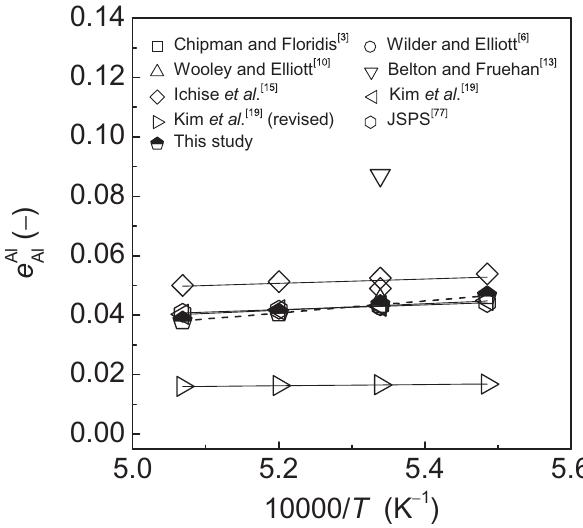
Figure 13: Comparison of reported results of first-order activity inter- action coefficient e Al of Al by various researchers with obtained ones Al by developed AMCT – N i model for Fe – Al binary melts over a tempera- ture range from 1823 to 1973 K (1550 to 1700°C),